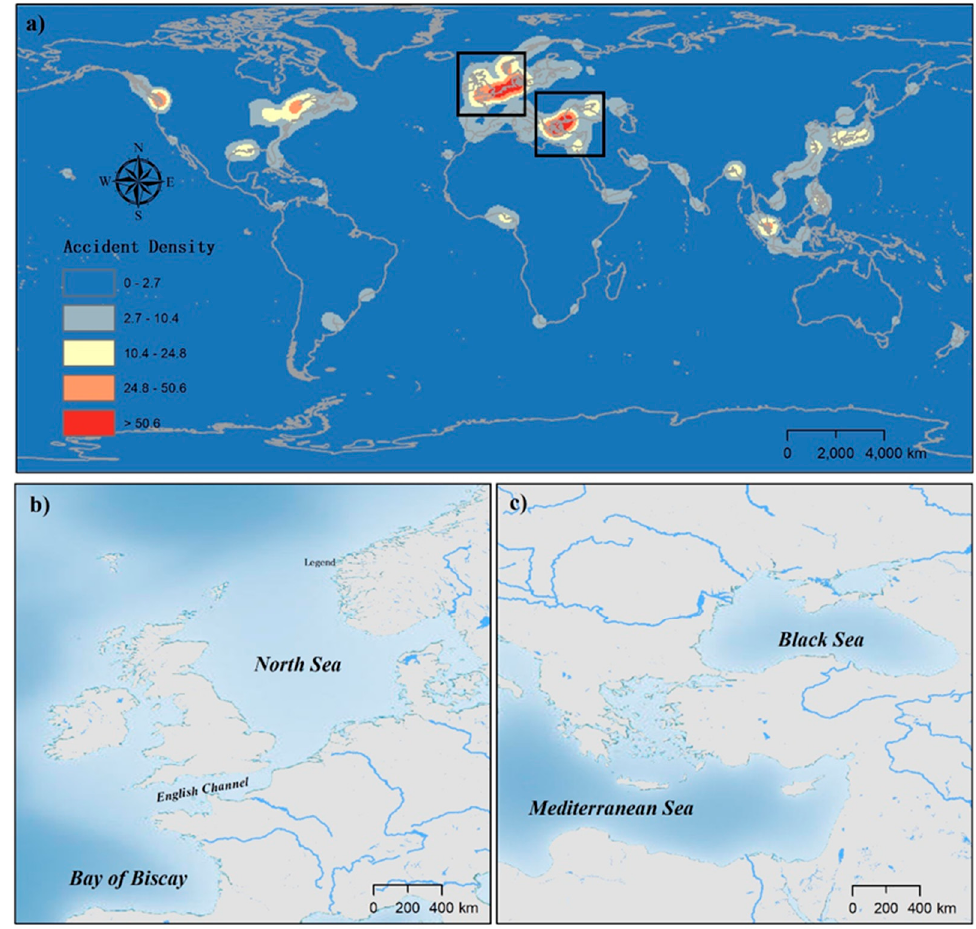
Figure 3. Maps showing ( a ) density of global maritime accidents and the geographic locations of ( b ) Area I and ( c ) Area II. ( b ) Area I and ( c ) Area II.